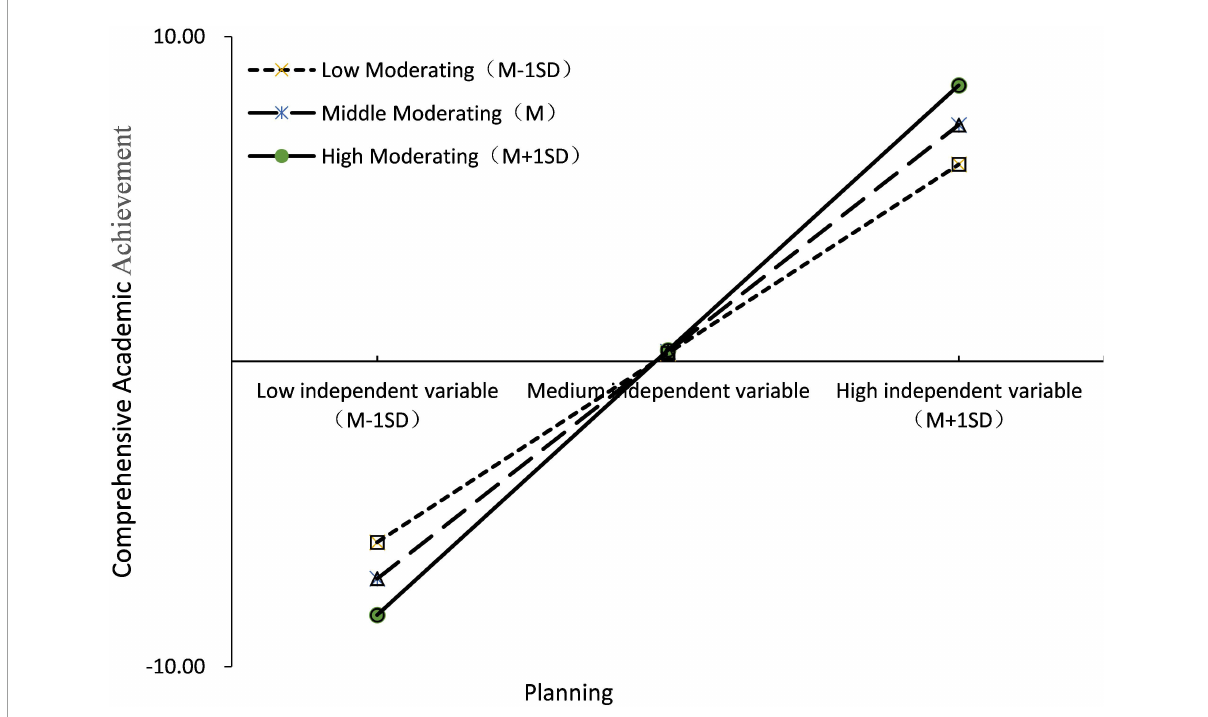
FIGURE3 Simple slope test (comprehensive academic